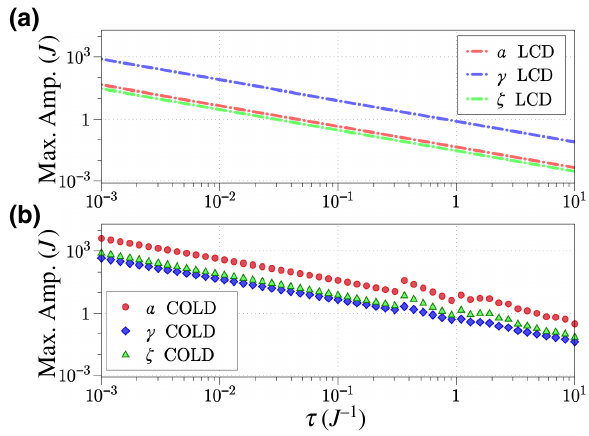
FIG. 3. Maximum amplitudes of CD terms in the Ising model annealing protocol for (a) first- and second-order LCD only with no additional optimal control fields and (b) the COLD approach optimized for the best final state fidelity implementing first-order LCD as shown in Fig. 2(a). The plot shows the maximum ampli- tude at each driving time for the first-order α (red circles) and the two second-order terms γ (blue diamonds) and ζ (green trian- gles) as given in Eq. (26) (although the second-order LCD is not actually implemented in COLD). An inversion in the strength of the second-order and first-order LCD terms for (a) no additional optimal control fields and (b) the addition of optimal control fields shows that COLD implements a dynamical Hamiltonian that is favorable for the applied order of LCD (first order in this case).